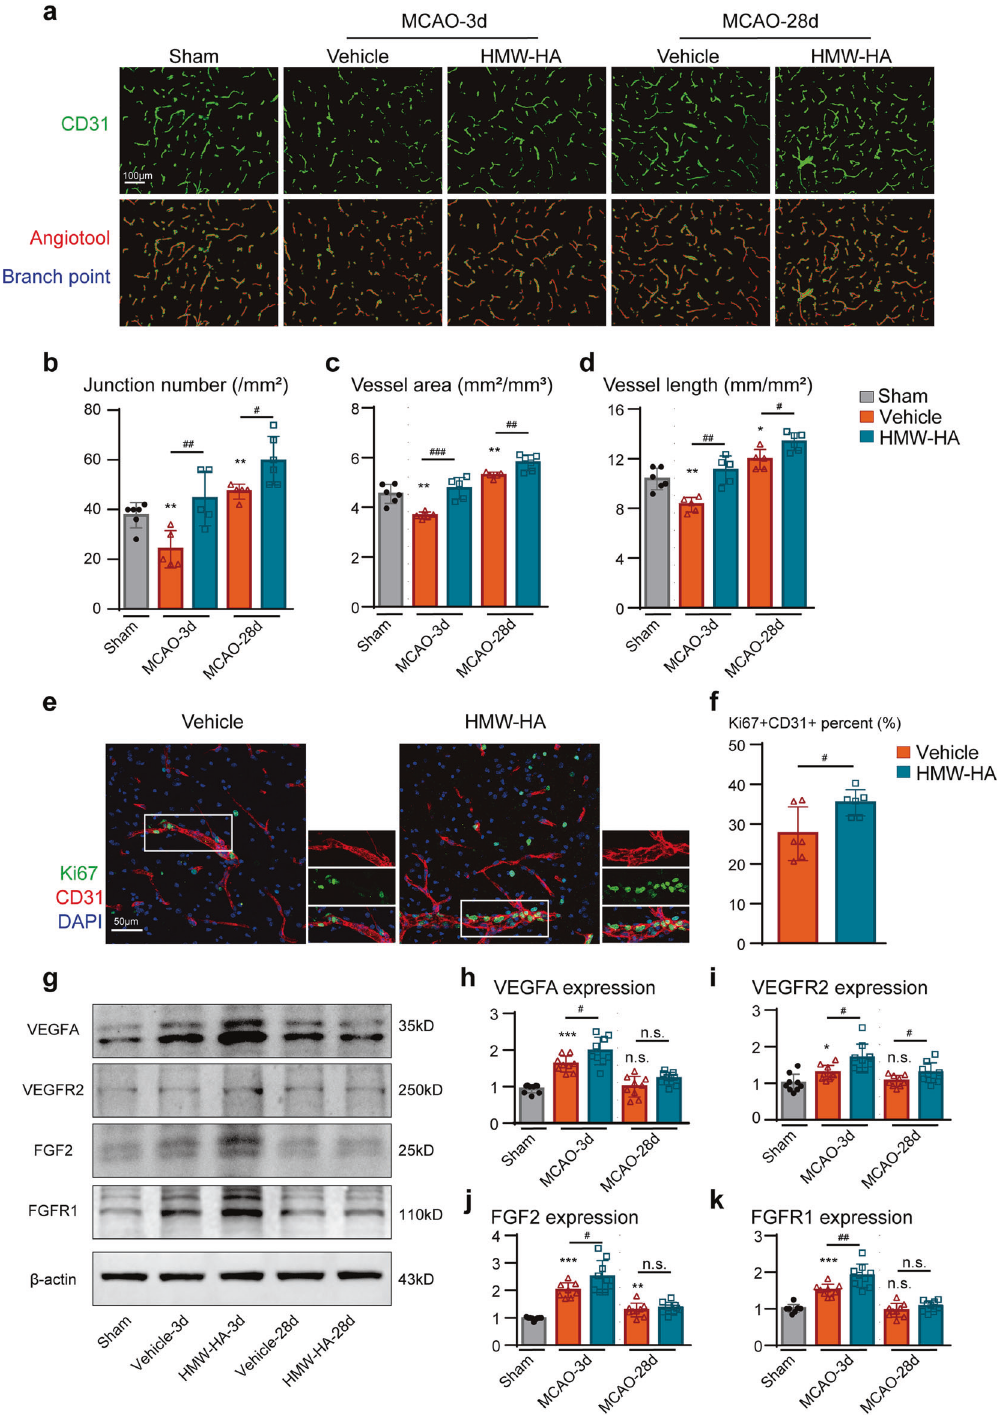
Fig. 4 Suppression of FSAP by HMW-HA treatment enhances revascularization and newly formed microvessels in the penumbral regions of mouse brains after cerebral ischemia. a – d Cerebral vasculature was detected and quanti fi ed by CD31 (green) immunostaining in the penumbral regions at 3 and 28 days after MCAO. a Representative CD31 immunostaining images, b quantitative analysis of junction number, c vessel area, and d vascular length. Data is expressed as mean ± SD; n = 5 – 7 for each group. * p < 0.05, ** p < 0.01 versus Sham group, # p < 0.05, ## p < 0.01, ### p < 0.001 versus vehicle group by one-way ANOVA followed by Tukey ’ s multiple comparison tests. e , f CD31 (red) and Ki67 (green) double-immunostaining was used to determine the newly formed microvessels in the penumbral regions of the brains at 3 days after MCAO. e Representative images, and f quanti fi cation of the Ki67 + /CD31 + signals. Scale bar, 50 μ m. Data is expressed as mean ± SD; n = 5 – 7 for each group; # p < 0.05 versus vehicle group by Student ’ s T -test. g – k Pro-angiogenic factors expression was detected by Western blot. g Representative western blot images and h – k quantitative analysis. Data is expressed as mean ± SD; n = 9 for each group. n.s. not signi fi cant, * p < 0.05, *** p < 0.001 versus Sham group, n.s. not signi fi cant, # p < 0.05, ## p < 0.01 versus vehicle group by one-way ANOVA followed